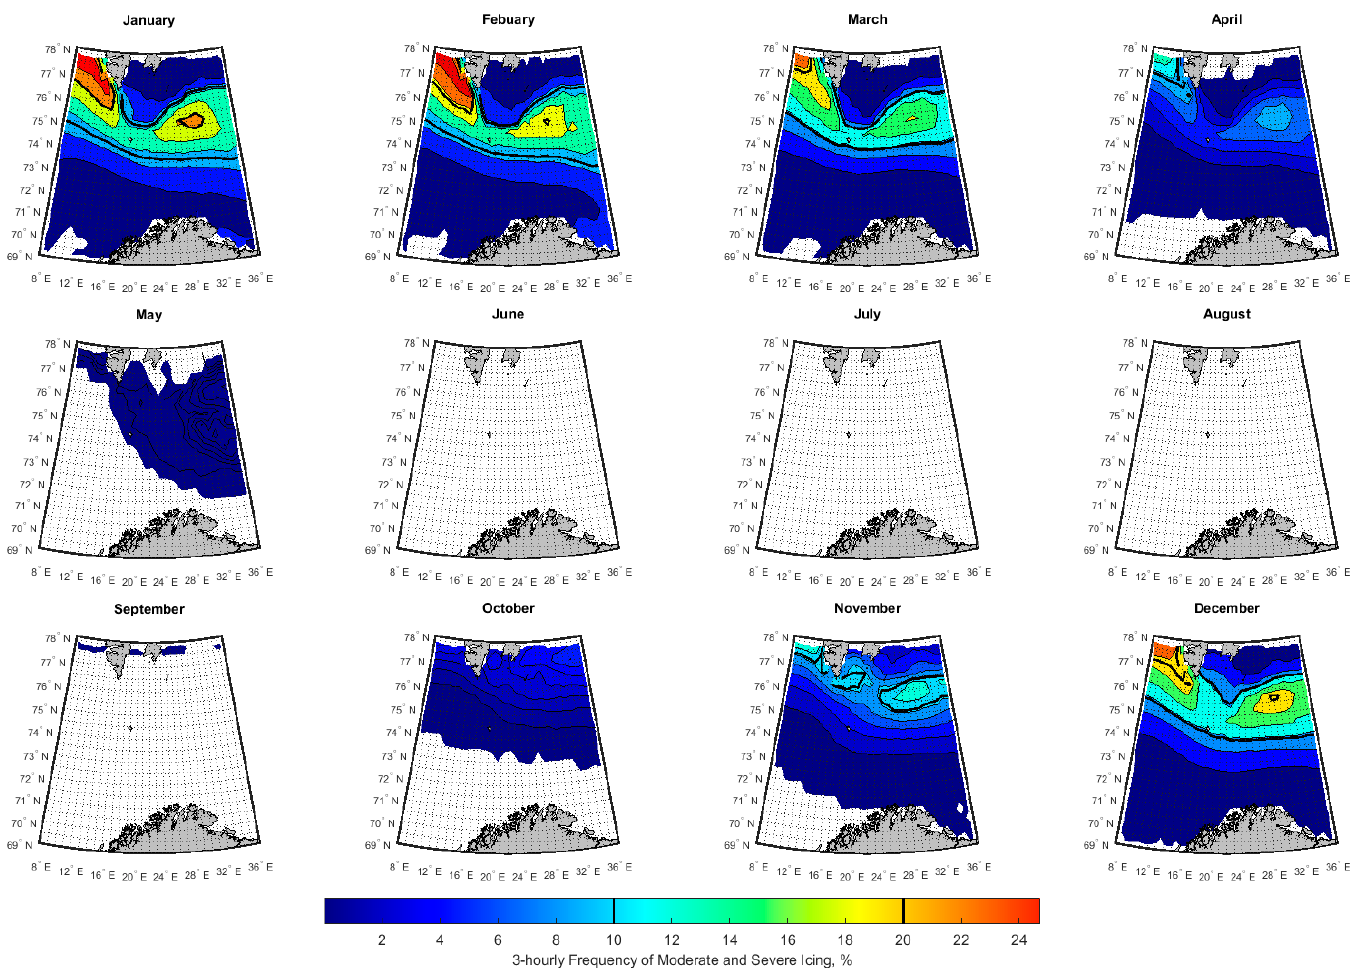
Figure 9. Three-hourly frequency of moderate and severe icing in each month. The 10% and 20% frequency isolines are represented as black lines.